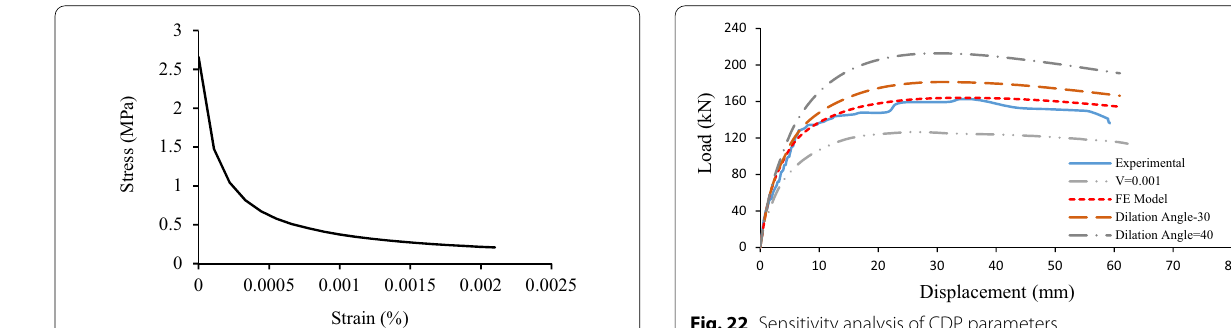
Fig. 20 Tensile behavior of concrete (Lubliner et al., 1989).